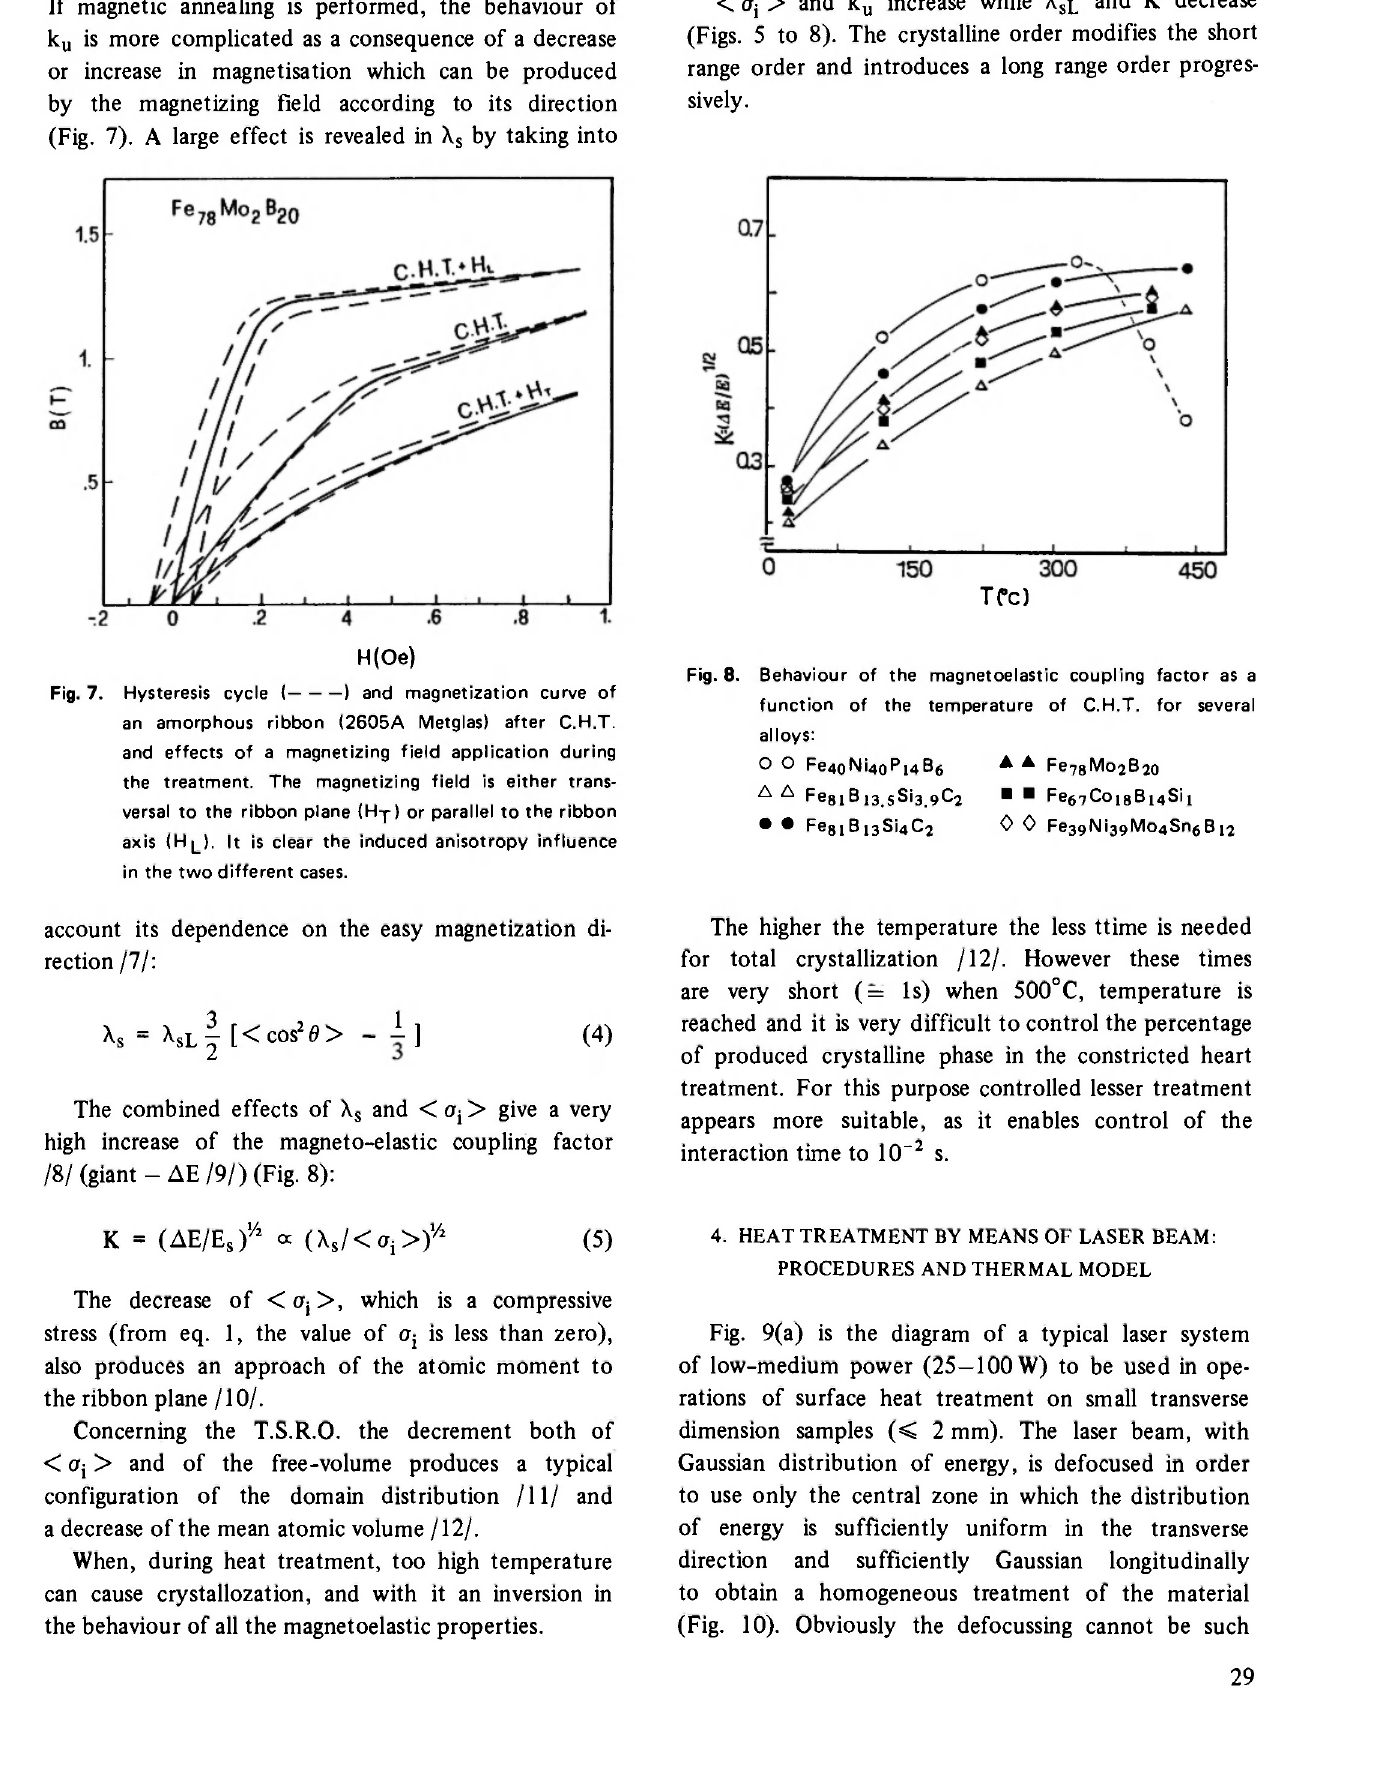
Fig. 7. Hysteresis cycle ( ) and magnetization curve of an amorphous ribbon (2605A Metglas) after C.H.T.